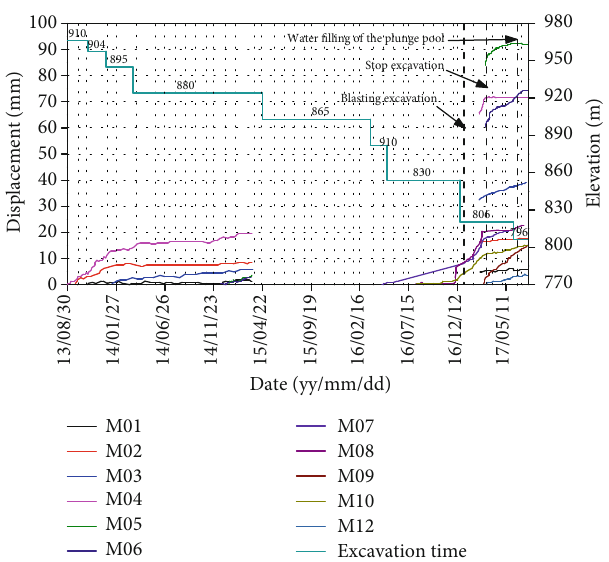
Figure 6: Relationship between the deformation of the multipoint displacement meter and the excavation